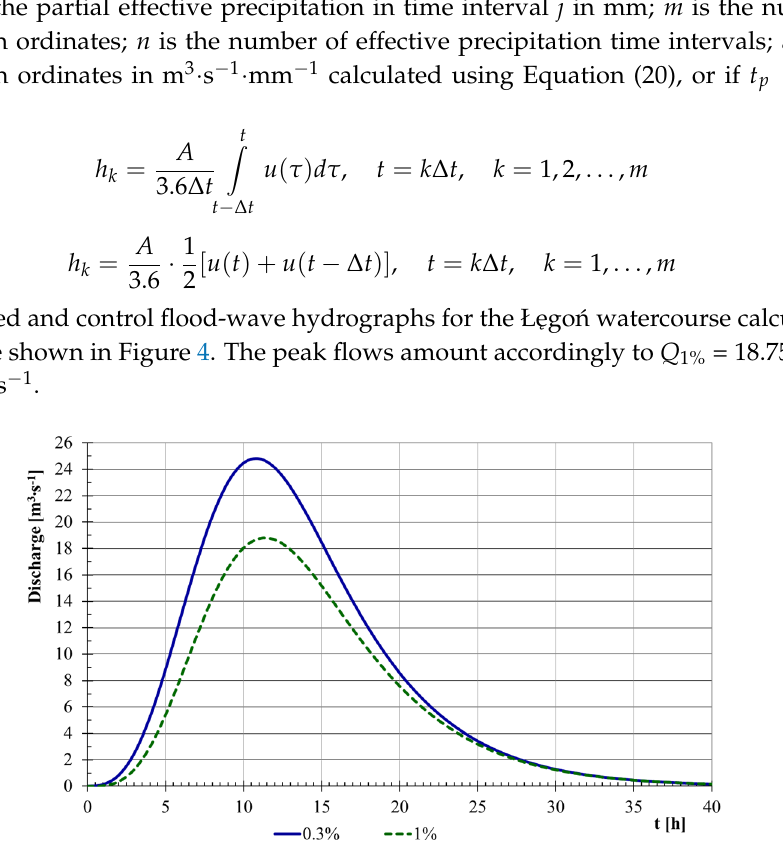
Figure 4. Hydrographs of the designed and control flood waves for p = 1% and 0.3%.